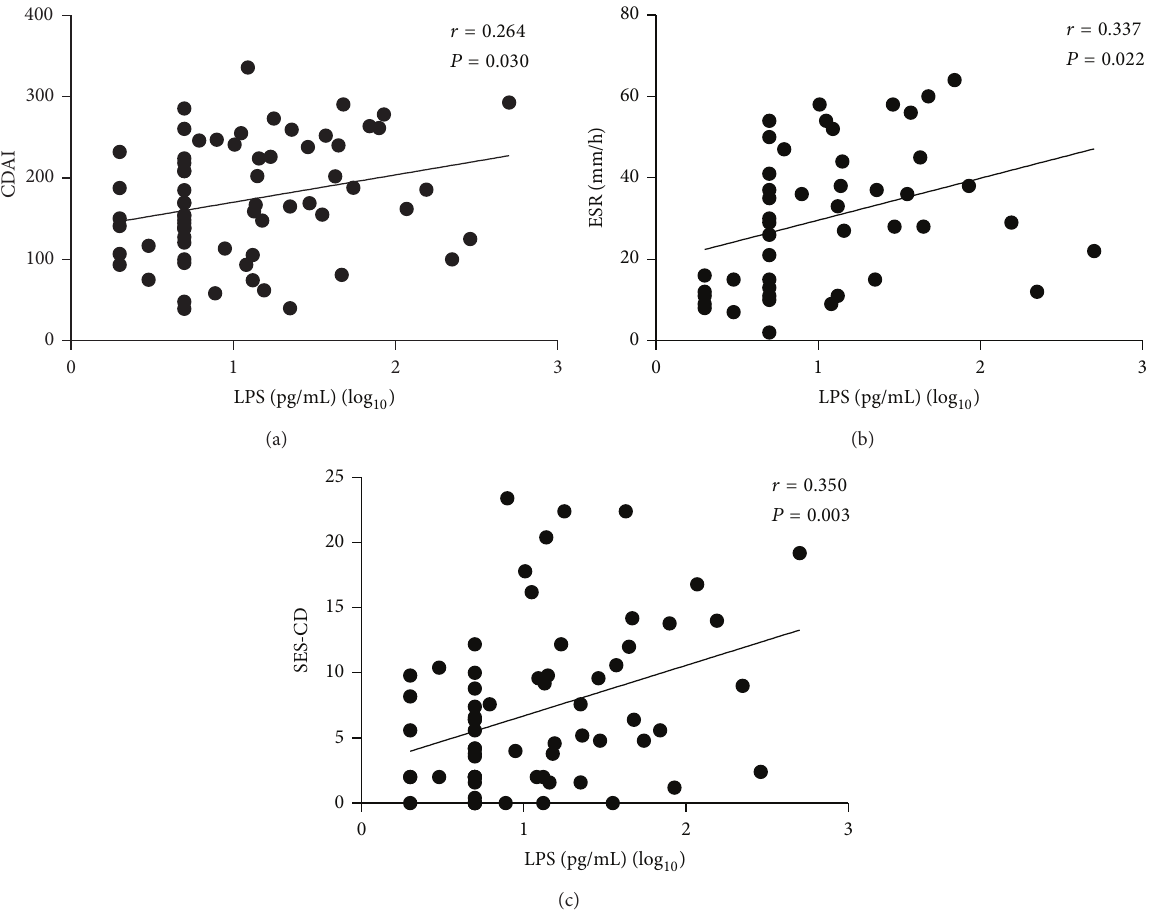
Figure 2: Correlation analysis among CDAI, ESR, and SES-CD and the levels of LPS in CD patients. Correlation between CDAI and LPS ((a), 𝑟 = 0.264 , 𝑃 = 0.03 ) in all CD patients. Correlation between ESR and LPS ((b), 𝑟 = 0.337 , 𝑃 = 0.022 ) in all CD patients. Correlation between SES-CD and LPS ((c), 𝑟 = 0.350 , 𝑃 = 0.003 ) in all CD